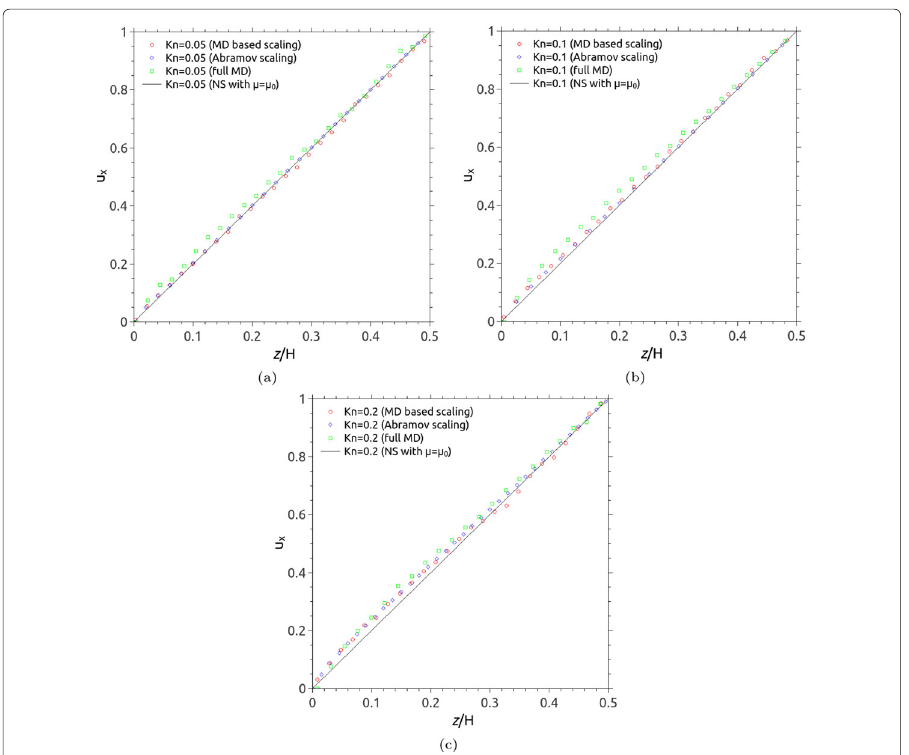
Fig. 8 Velocity profiles of the micro-Couette gas flow for: a Kn = 0.05; b Kn = 0.1; and c Kn = 0.2. Open circles (red) and diamonds (blue) are based on the scaling laws from MFP in MD results and Abramov [24], respectively; open squares (green) refer to the full MD simulations results; the solid line refers to the Navier-Stokes solution with a constant viscosity. The data is plotted for only half the channel (i.e. above one of the surfaces) and the velocity is rescaled by half of the value for shearing